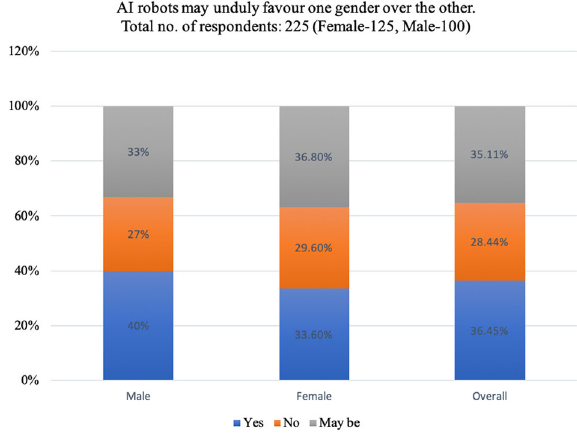
Fig. 7 Separate ethical norms for male and female robots are required. Total no. of respondents: 225 (Female: 125, Male: 100).